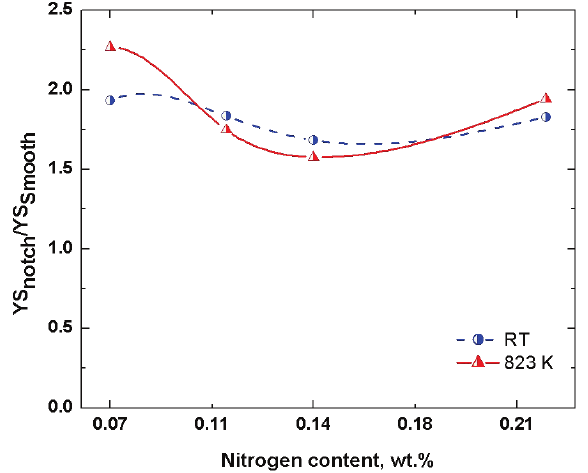
Figure 5. Influence of nitrogen on the ratio of yield strength of notched to smooth specimens at room tem- perature and 823